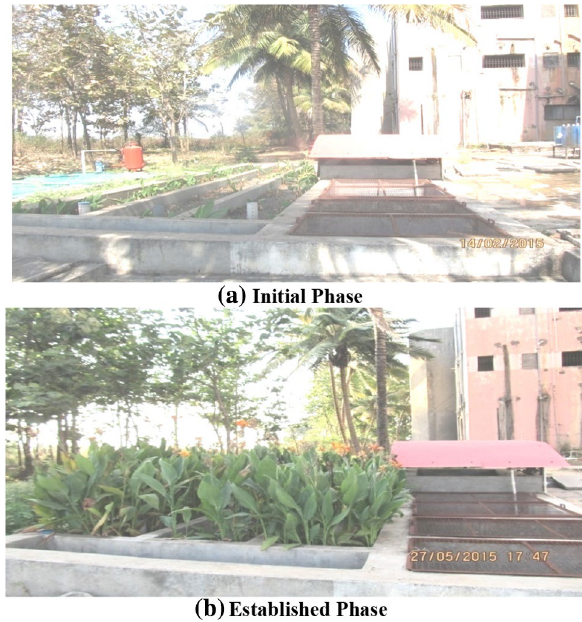
Fig. 2 Photographic view of